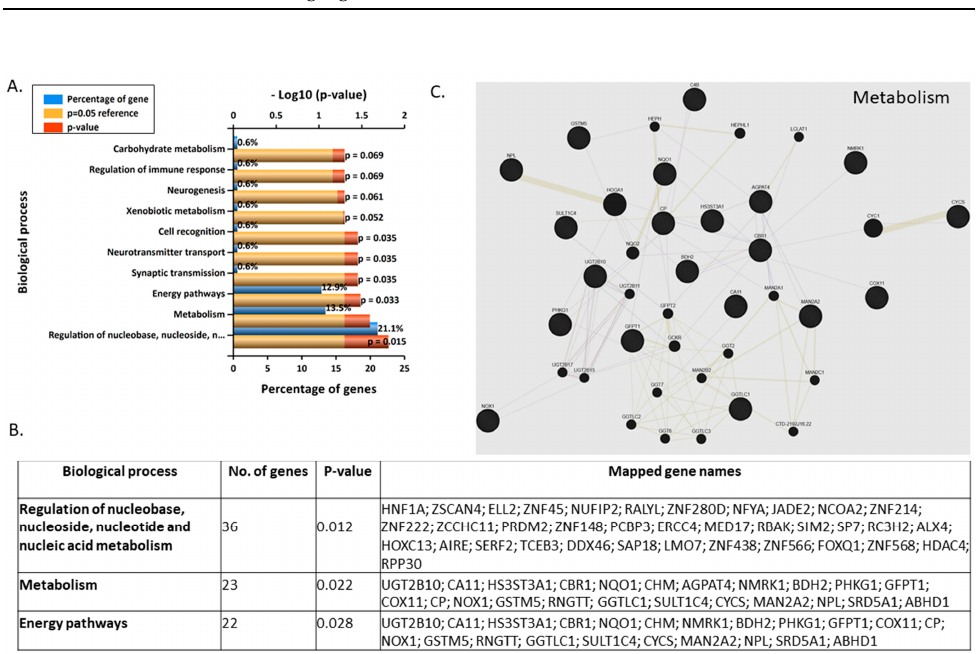
Figure 6. ( A ) Top 10 enriched (Funrich) biological processes for 3 nM BPA-treated syncytialised BeWos. ( B ) Table of genes involved in most significant biological processes. ( C ) Network annotation of genes involved in metabolism (Genemania; Supplementary Table S4).